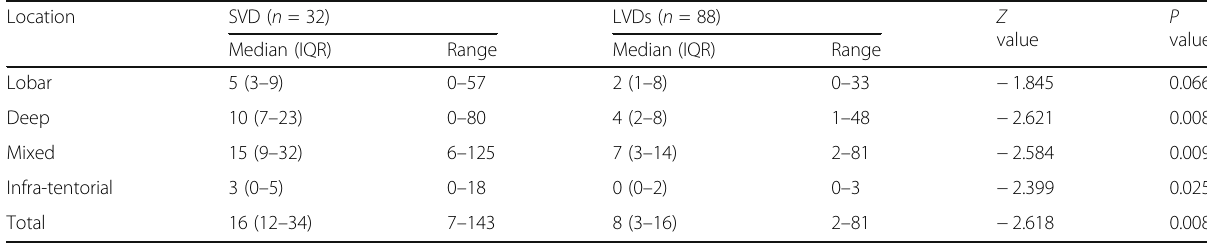
Table 2 Frequency and location of